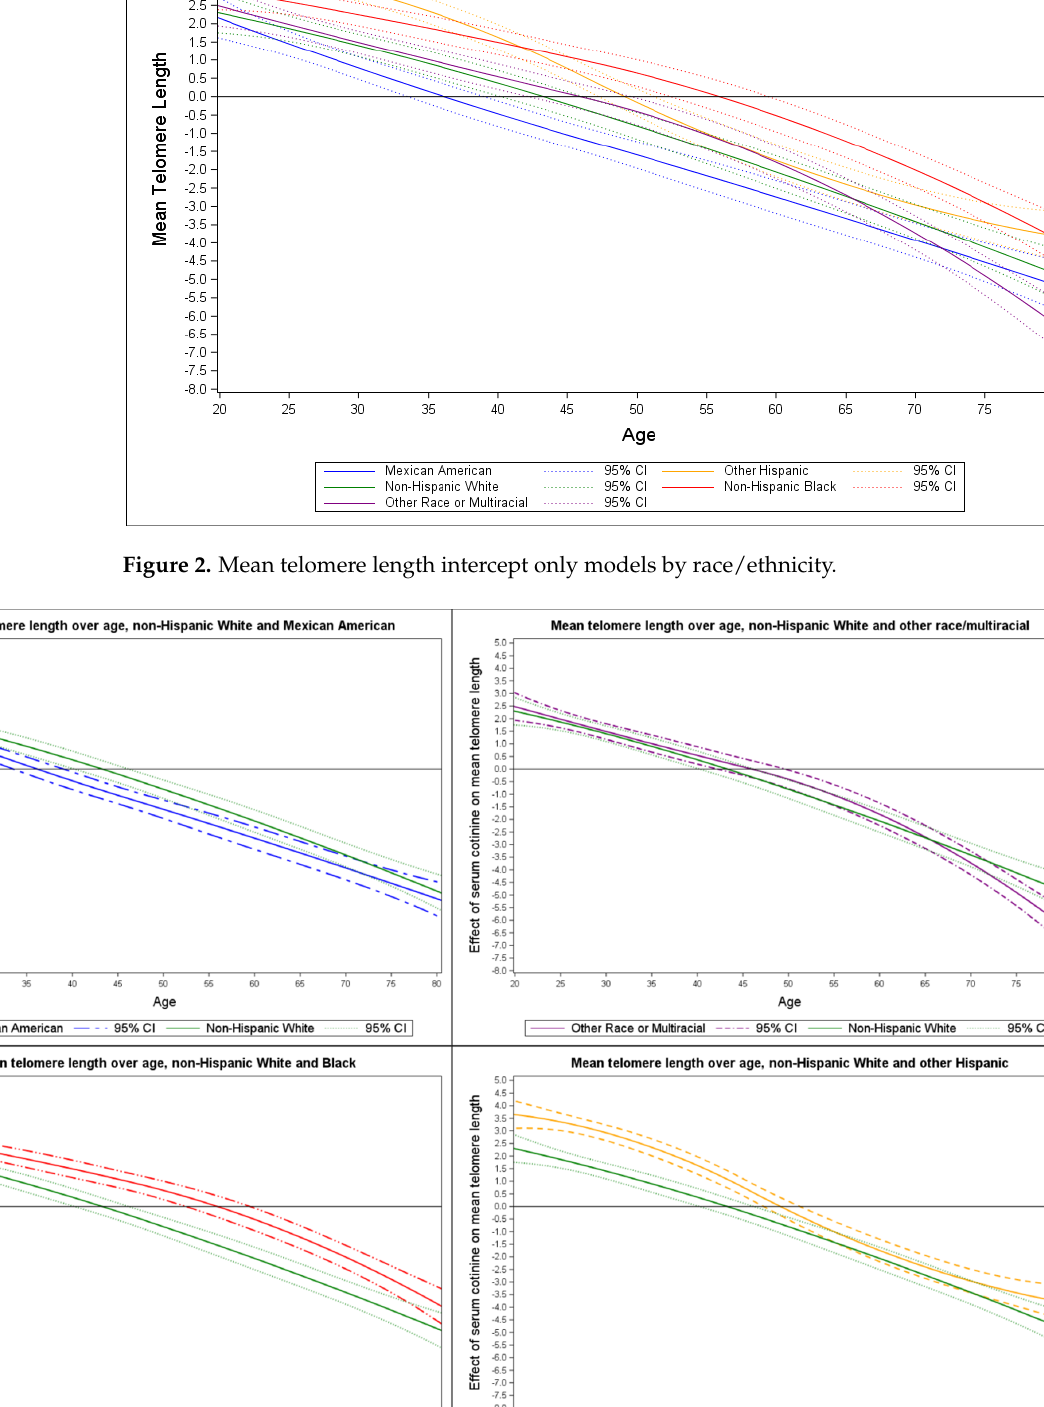
Figure 3. Effect of serum cotinine on mean telomere length by race/ethnicity compared to non-Hispanic White.